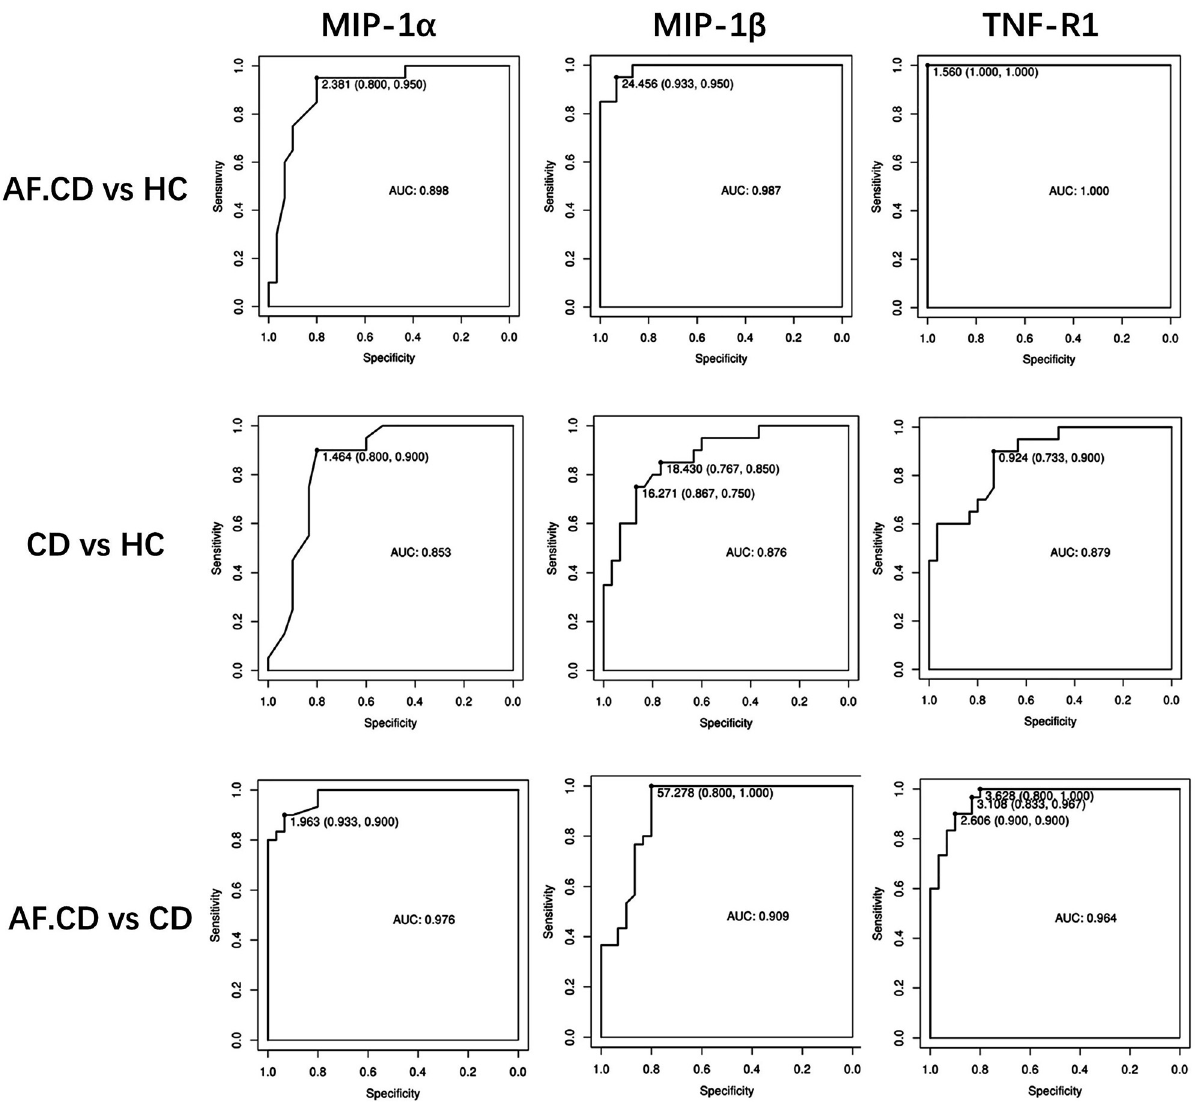
Figure 6: LDA analysis of MIP-1 α , MIP-1 β and TNF-R1 detected by ELISA. MIP-1 α , MIP-1 β and TNF-R1 in samples of anal fistula with chronic diarrhea patients (n=30), chronic diarrhea only patients (n=30) and healthy stula with chronic diarrhea; CD, chronic diarrhea; HC, healthy